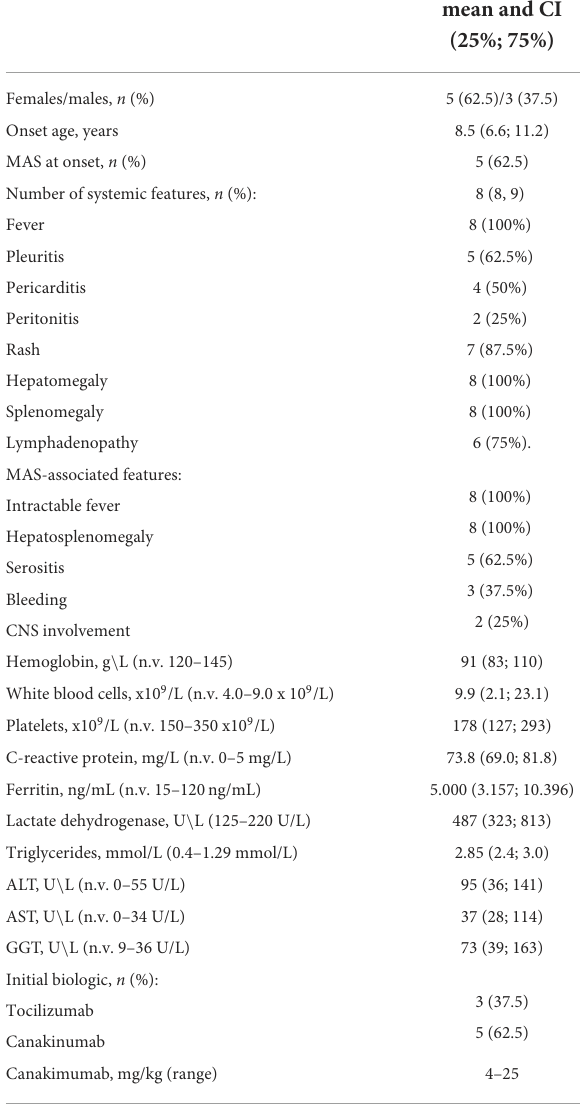
TABLE 1 Demographic, clinical, and laboratory features of sJIA patients during the MAS episodes. Parameter Results n (%) or